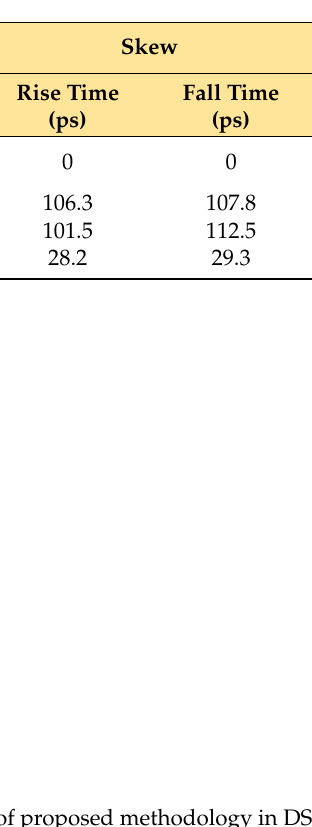
Table 5. Skew results after CTS using our proposed methodology.